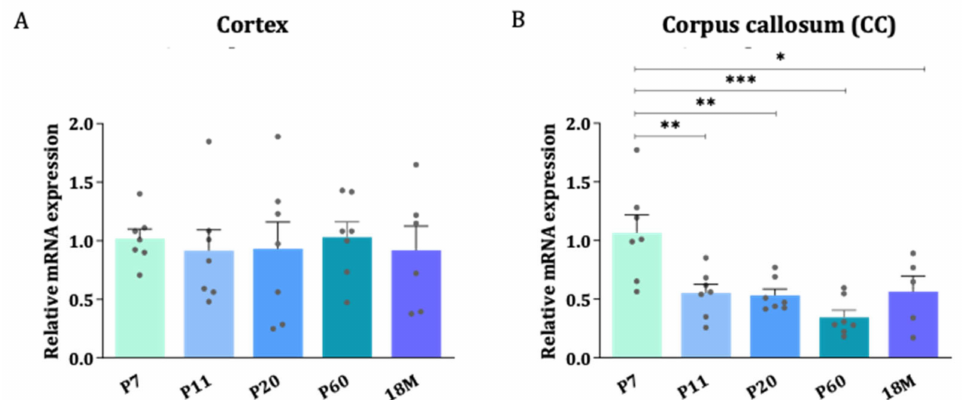
Figure 2. The stability of AQP4 mRNA levels during brain development in the cortex con-trasts with a reduction in gene expression in the corpus callosum. Relative expression changes of AQP4 mRNA measured by RT-qPCR in cortex ( A ) and CC ( B ) across different developmental stages. n = 6–7 animals per group. Mean values are represented with the standard error of the mean (SEM). Statistically significant differences between mean values were assessed by ANOVA test with post hoc TUKEY multiple comparison test (* p < 0.05, ** p < 0.01, *** p <